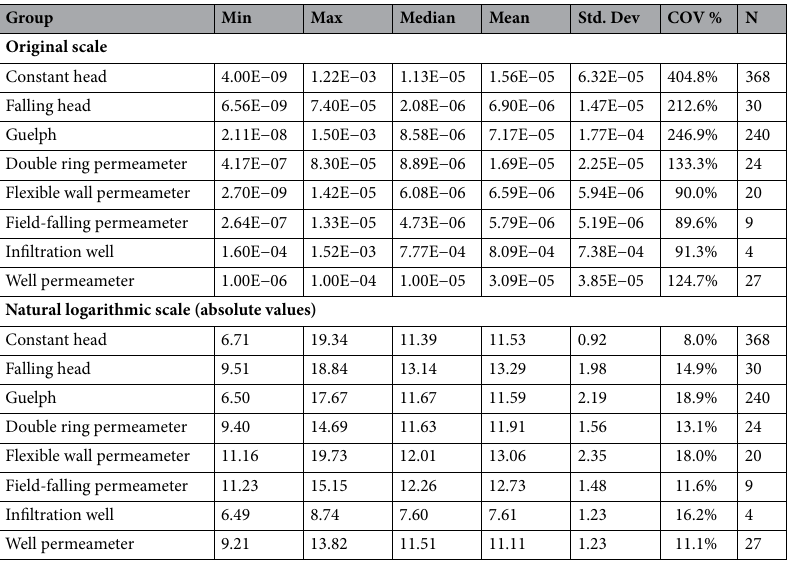
Table 3. Data statistics for k sat values and absolute values of ln ( k sat ). COV Coefficient of variation, N number of